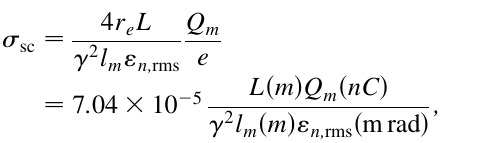
Table I. At 0.5 pC the space charge effects start becoming